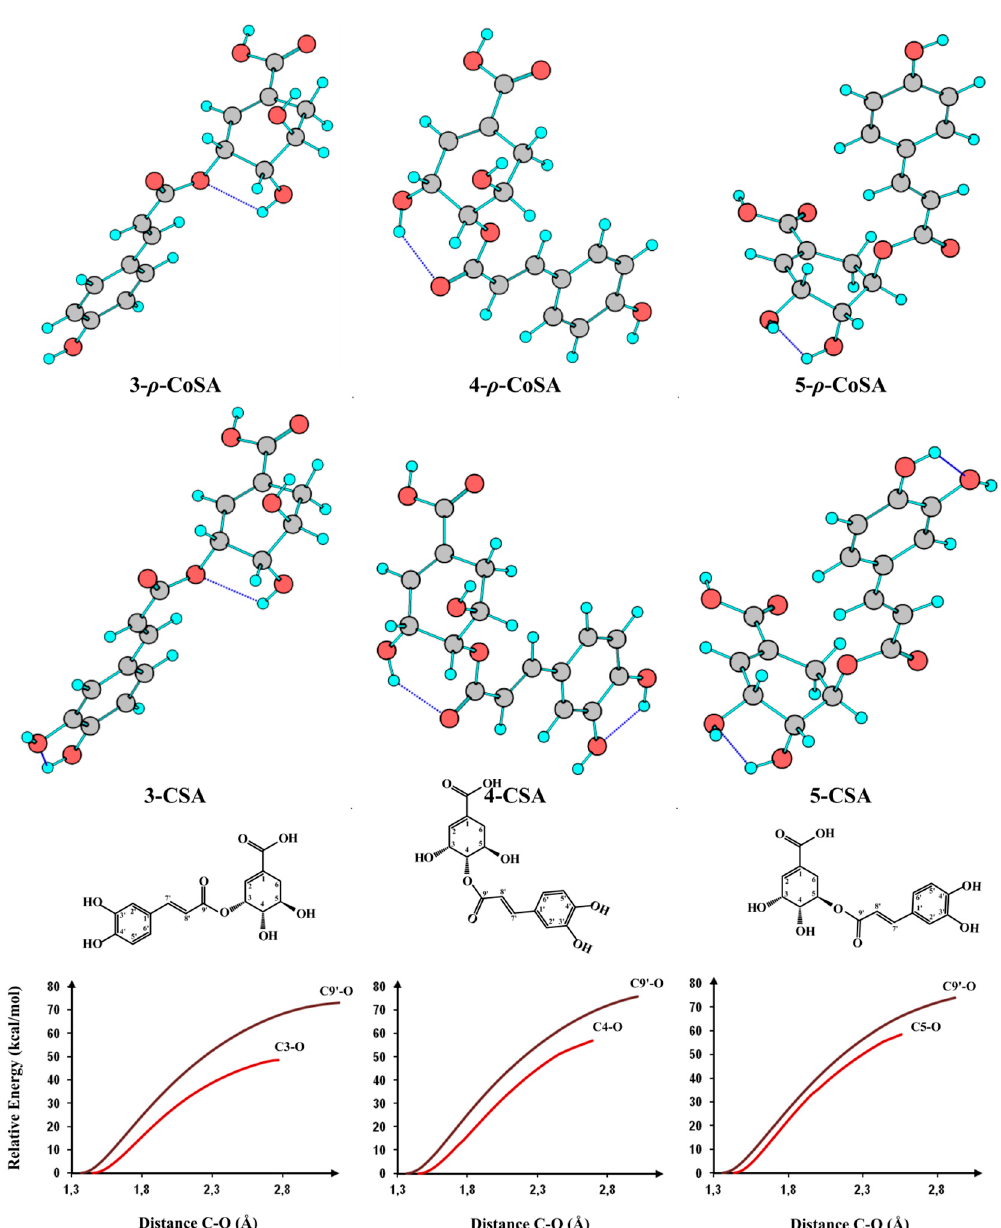
Figure 3. Optimized geometries of caffeoylshikimic acid isomers (CSA) and p -coumaroylshikimic acid isomers ( p -CoSA) calculated at the B3LYP/6-31 + G(d,p) level, DFT/B3LYP relative energy along the scan of C–O distance.